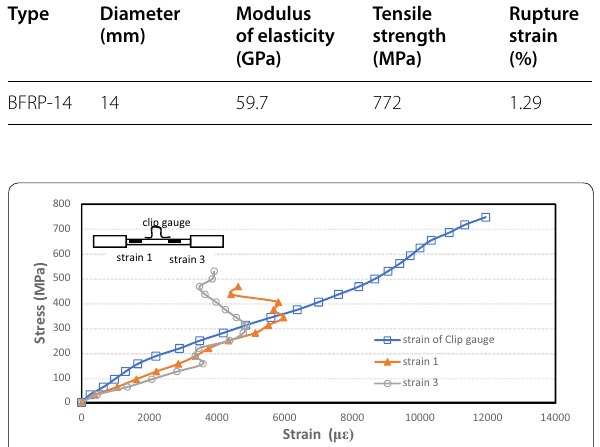
Fig. 3 Stress–strain relationship of the BFRP bars.